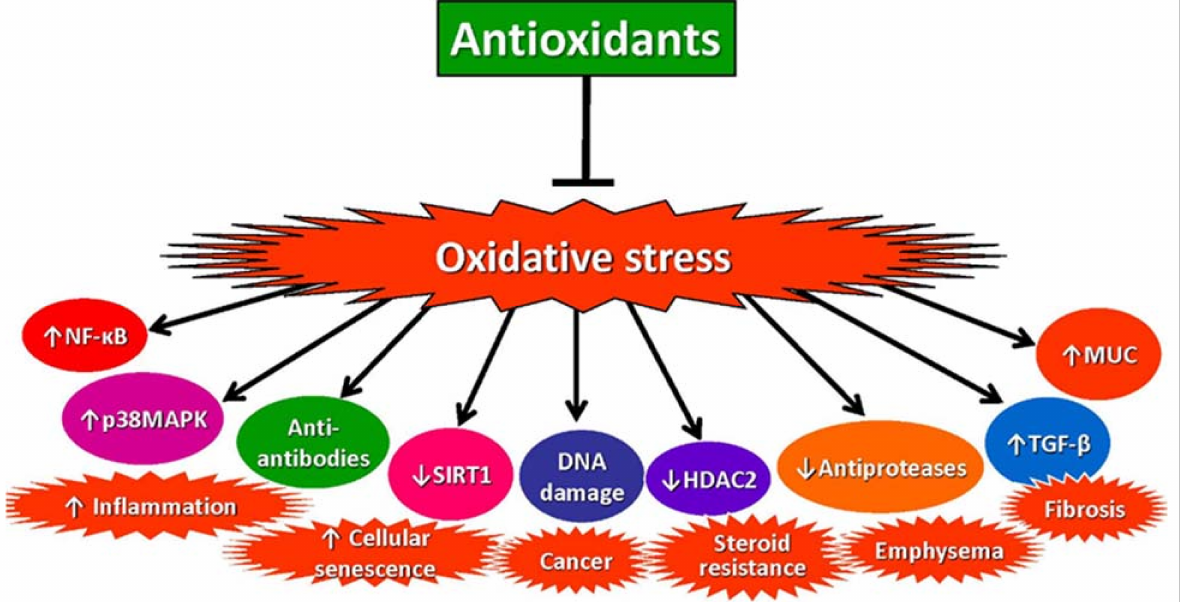
Figure 3. Increased oxidative stress drives the pathology of COPD through several mechanisms.